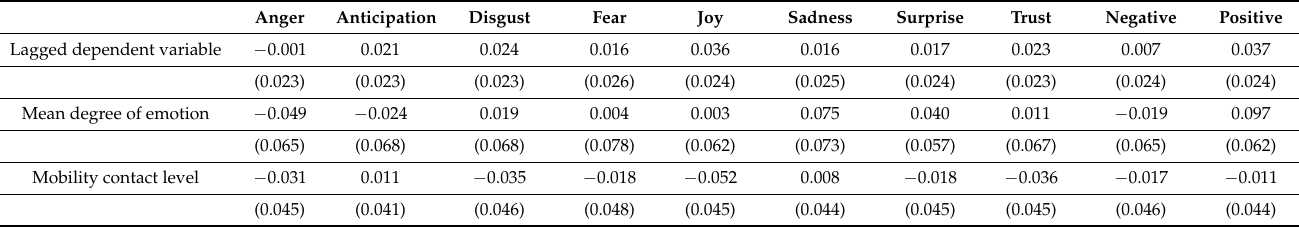
Table 4. Specific emotion